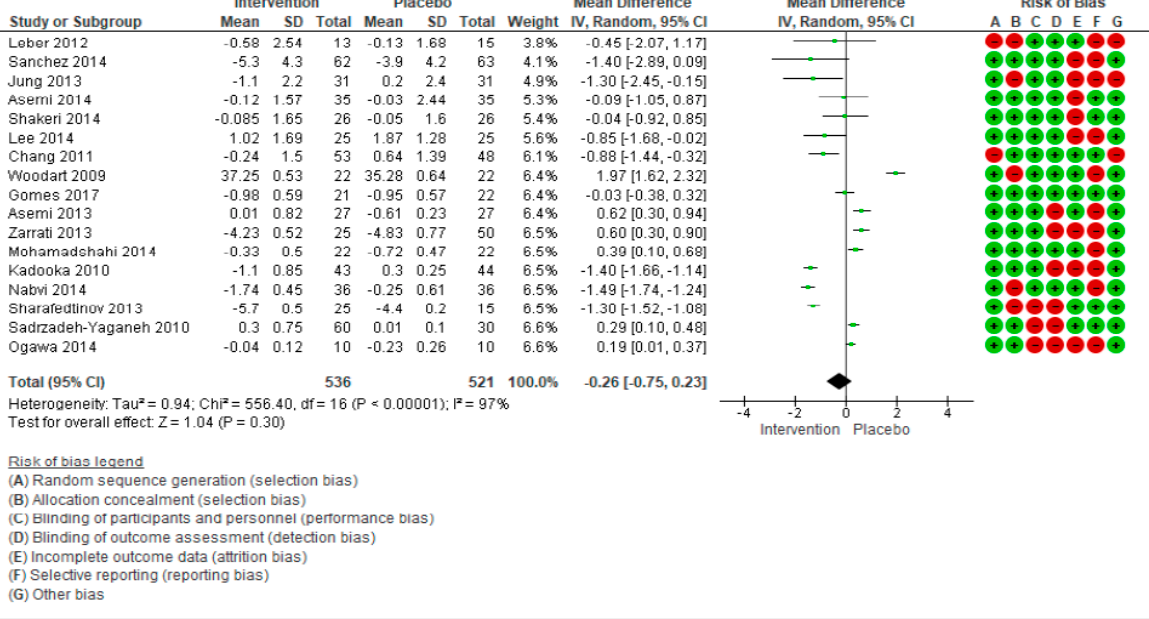
Figure 1. Forest plot for randomized controlled trials of probiotic supplementation included in body weight (kg) subgroup meta-analysis ( n = 1057). The studies are listed by first author and year. IV = equation that can be estimated by inverse variance (linear, exponential). The square represents the measures of effect (i.e., an odd ratio) for each study; the area of each square is proportional to the study’s weight in the meta-analysis. Horizontal line represents the confidence interval (CI) at the 95% level. The diamond represents the meta-analyzed measure of effect; the lateral points of diamond indicate CIs for this estimate. The vertical line represents no effects; if the CI for an individual study overlaps with this line, the given level of confidence for the effect size does not differ from no effect for that study. Risk of bias indicates the level of high and low risk associated with the article. With green signal for low risk and red for high risk of bias.